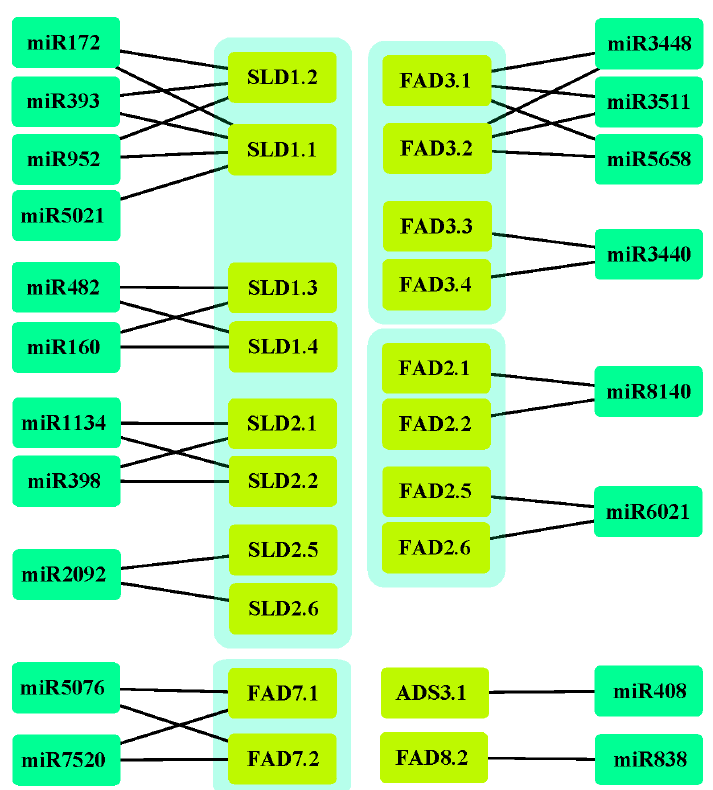
Figure 8. Interaction network of miRNAs and their target Ah|FADs.